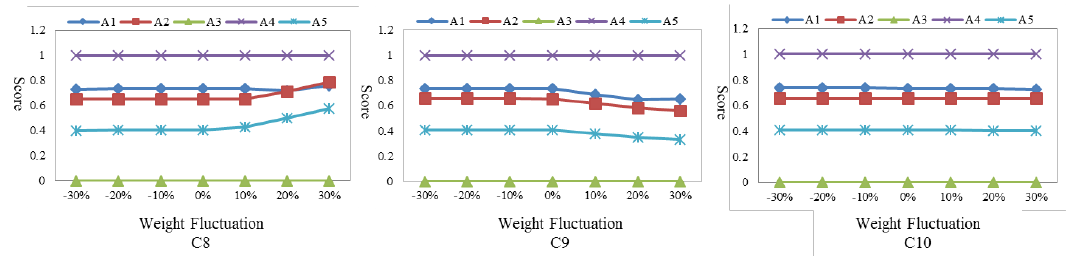
Figure 7. Sensitivity analysis results of the sub-criteria in the environment group.